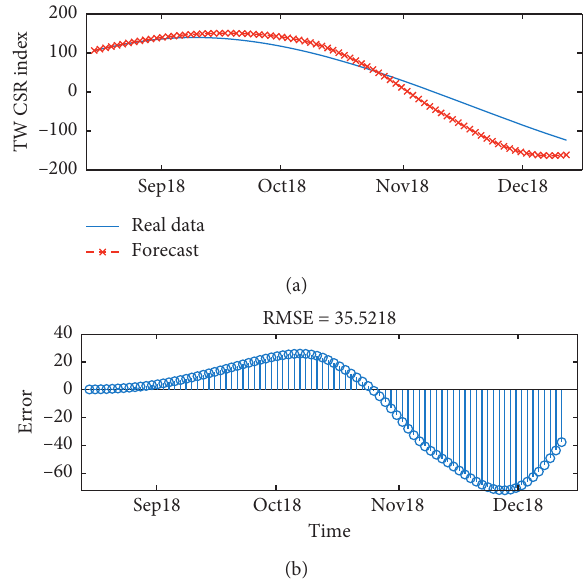
Figure 19: LSTM prediction and actual verification results for IMF5 with RMSE of 35.5218.